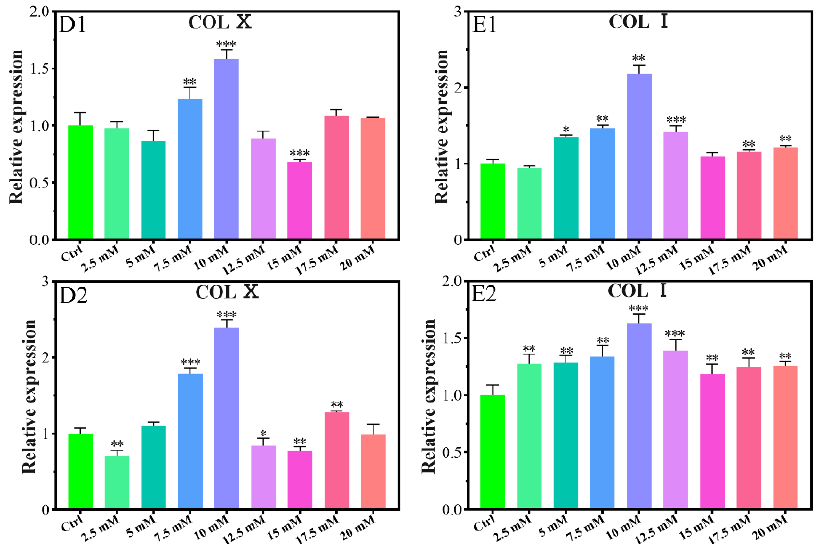
Figure 2. Effects of gene expression of chondrocytes cultured in different Mg 2+ concentrations on the 7th day ( A1 , B1 , C1 , D1 , E1 ) and the 14th day ( A2 , B2 , C2 , D2 , E2 ). All data are presented as fold change after normalization to GAPDH, and fold changes are shown as mean ± SD, * p < 0.05, ** p < 0.01, and *** p < 0.001.